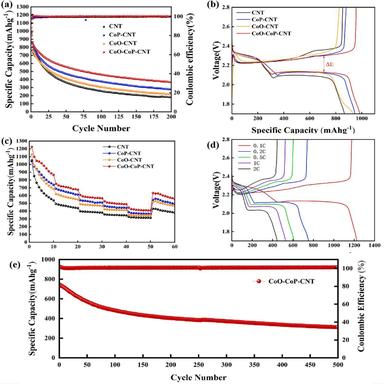
S/CoO-CoP-CNT, S/CoO-CNT, S/CoP-CNT and S/CNT positive electrode (a) Cycle performance at 0.2 C, (b) first cycle charge and discharge curve at 0.2 C and (c) rate performance. (d) Charge and discharge curves of the first circle under different positive ratios of S/CoO-CoP-CNT. (e) Cyclic performance and Coulomb efficiency of S/CoO-CoP-CNT positive electrode at 2 C.